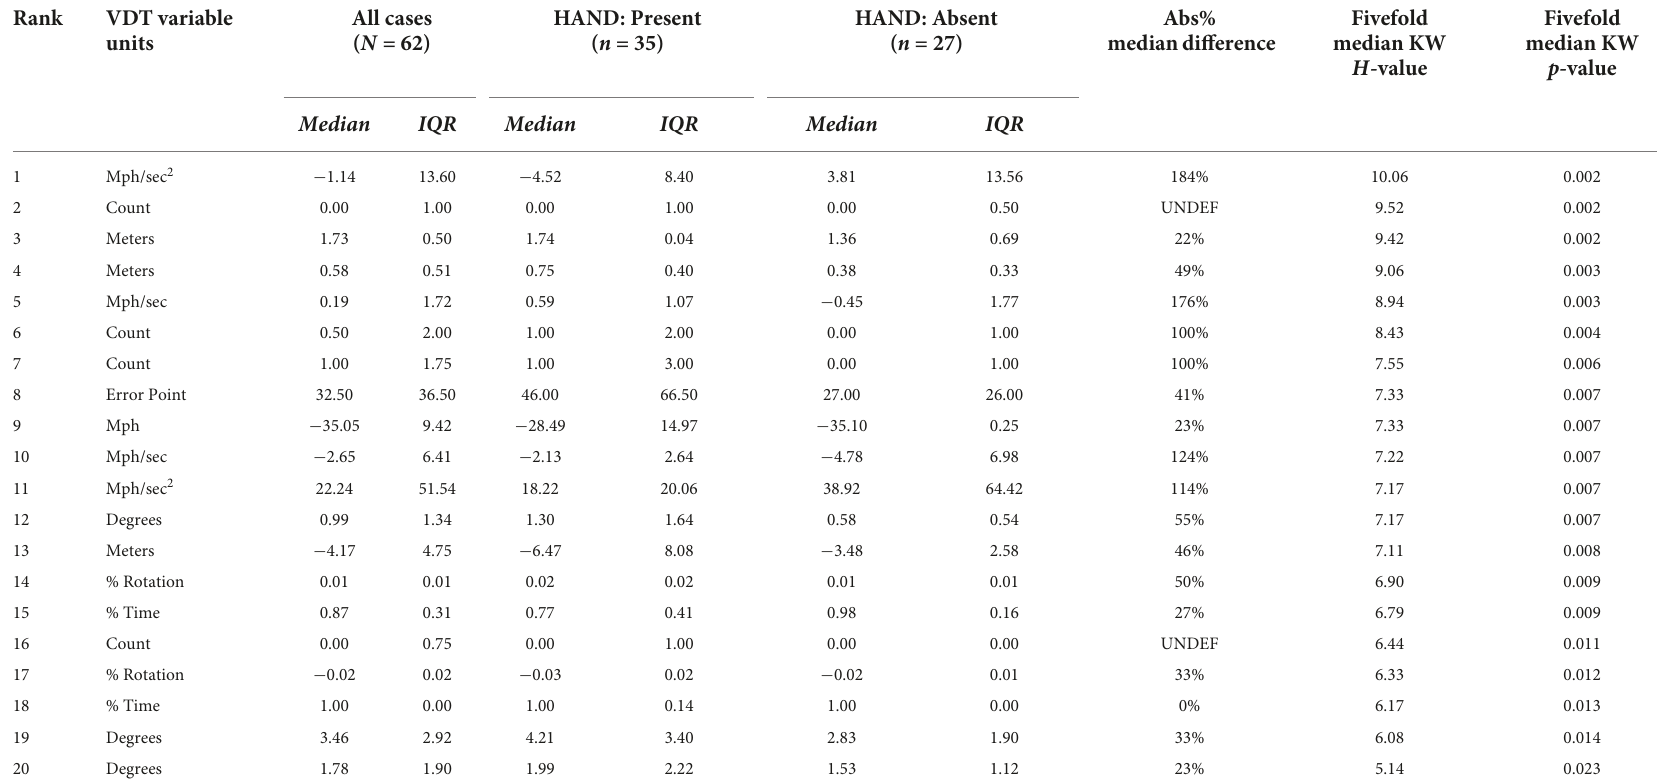
TABLE 6 Rank-ordered distributions of the 20 identified VDT